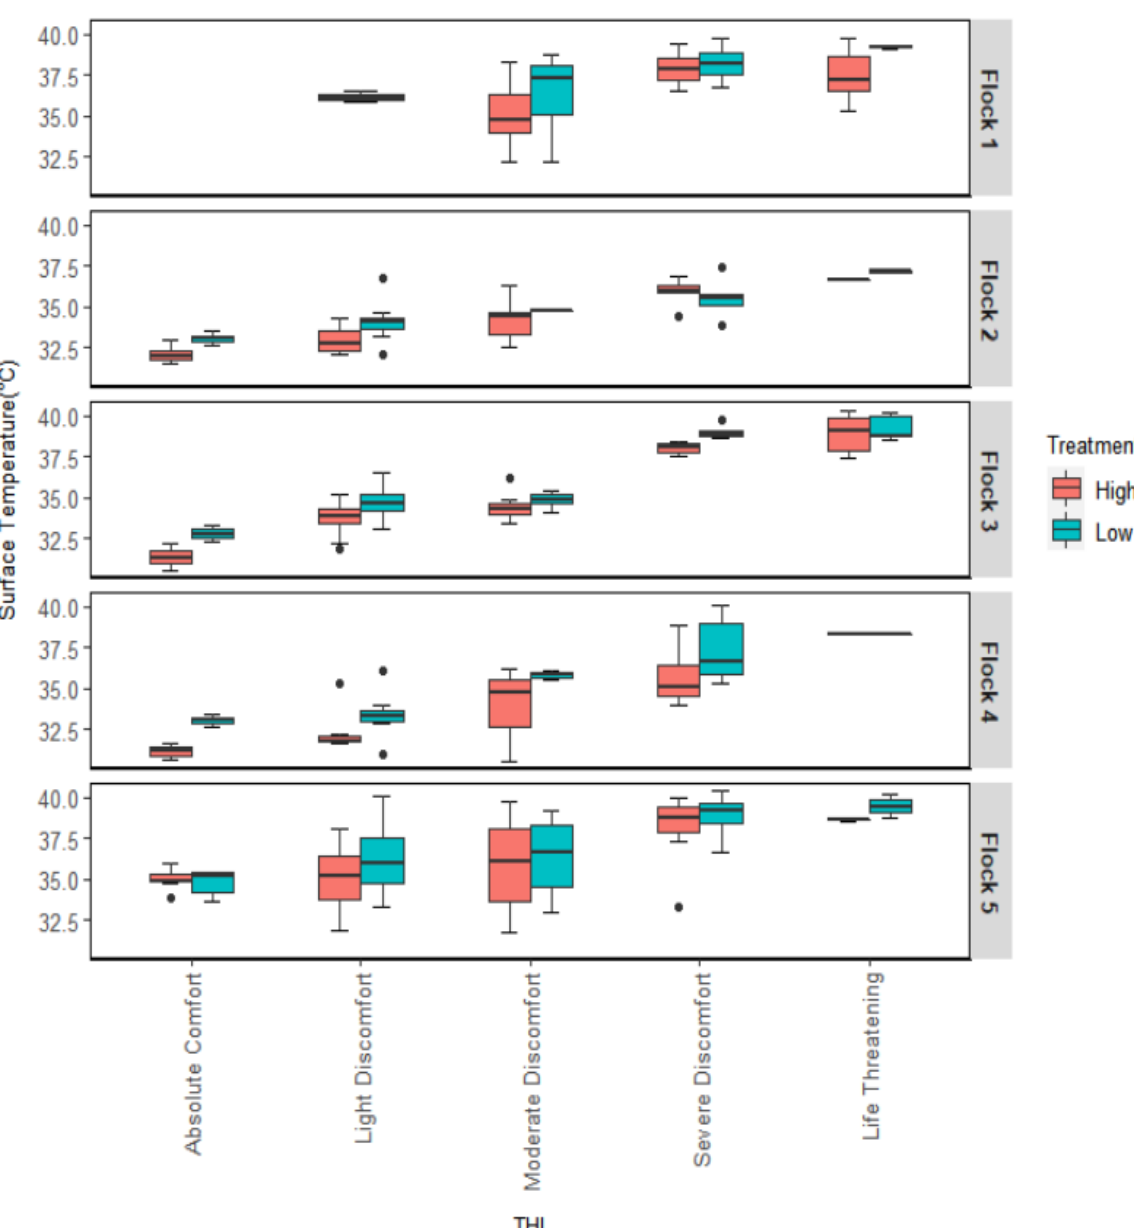
Figure 4. Variation in Ts for different THIs in different flocks under two AV treatments.